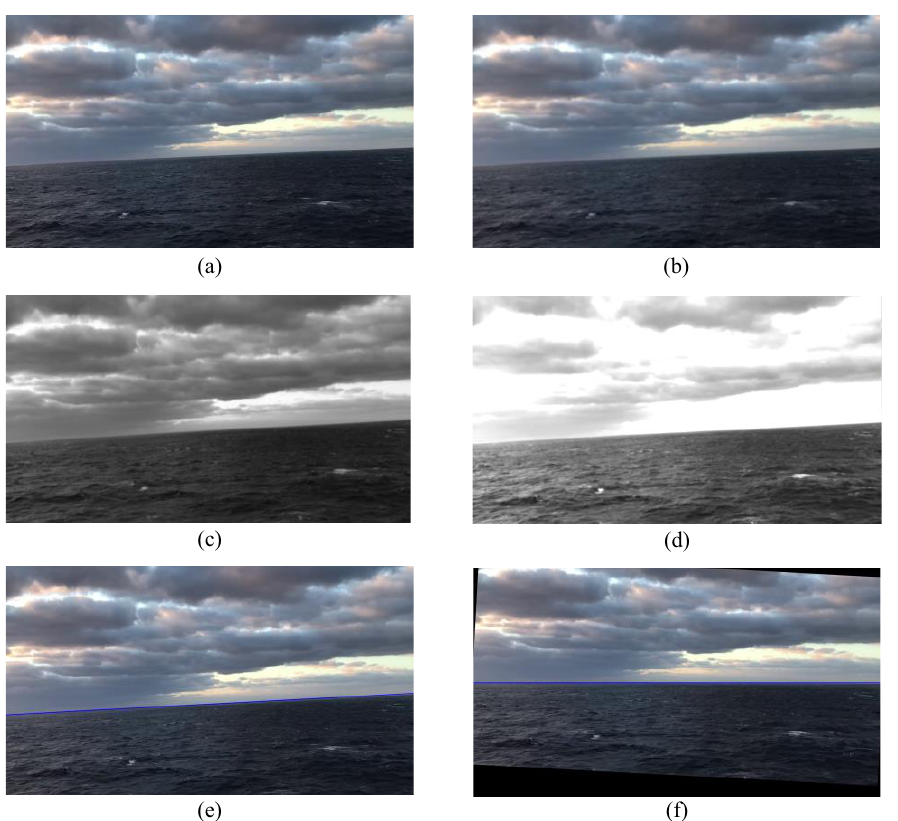
Figure 11. Process of electronic video stabilization. ( a ) The original picture; ( b ) Gaussian filtering; ( c ) gray-level image; ( d ) contrast adjustment; ( e ) Canny edge detection; ( f ) motion